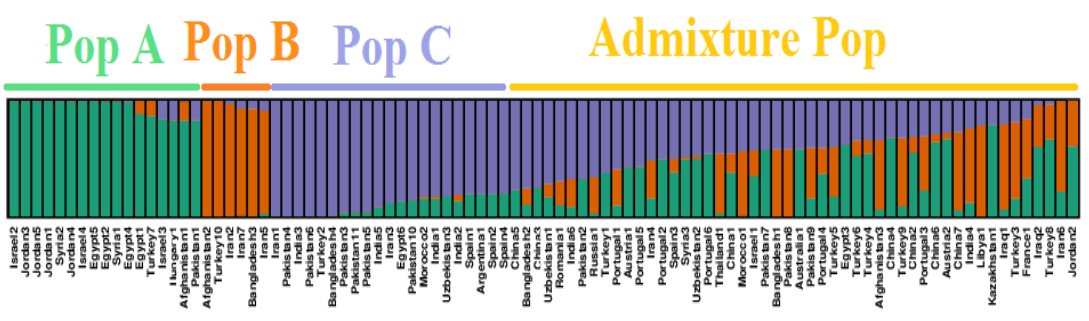
Figure 6. Structure-based clustering of the 94 safflower accessions using silicoDArT molecular markers.